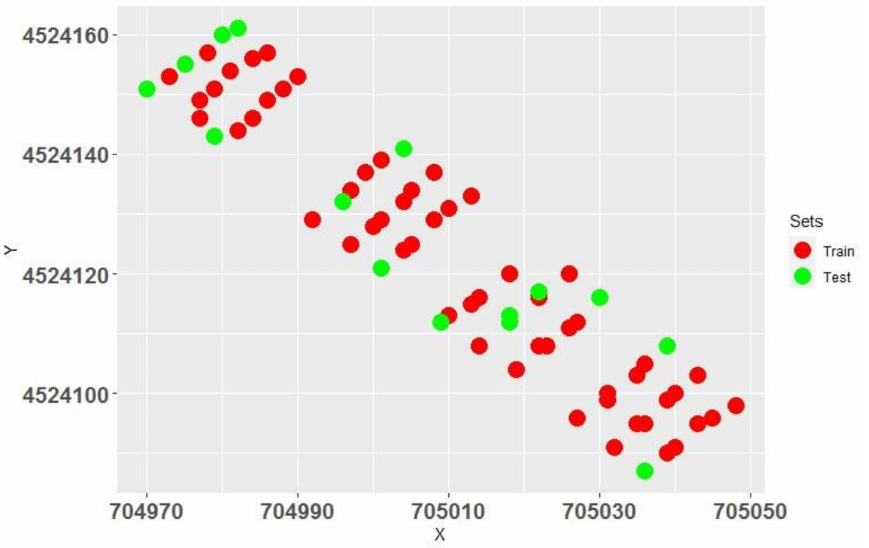
Figure 9. Spatial distribution of training and test sets